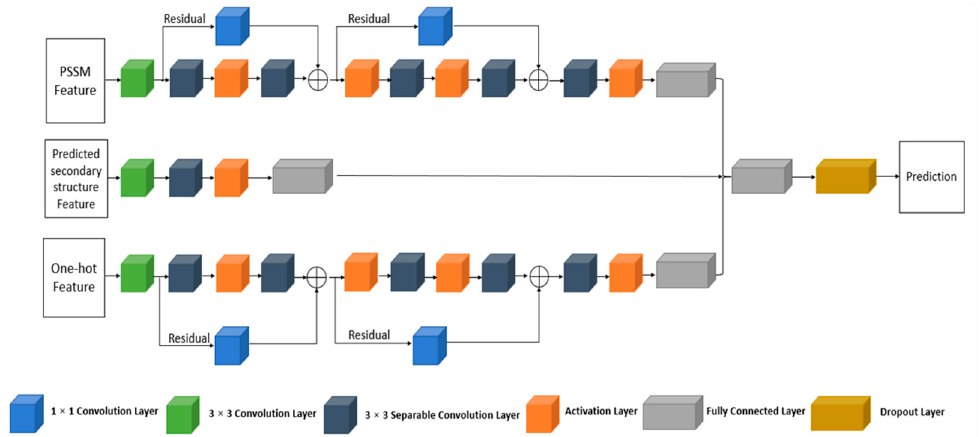
Figure 8. The structure of the proposed multi-Xception-based predictor.